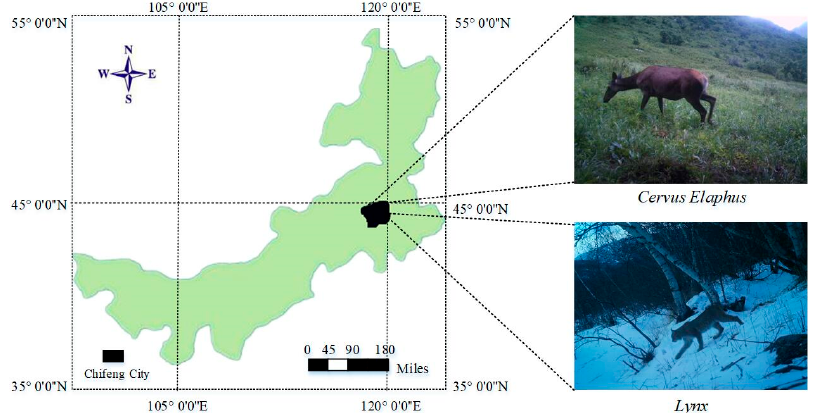
Figure 2. Wildlife monitoring images in Saihan Ula Nature Reserve.